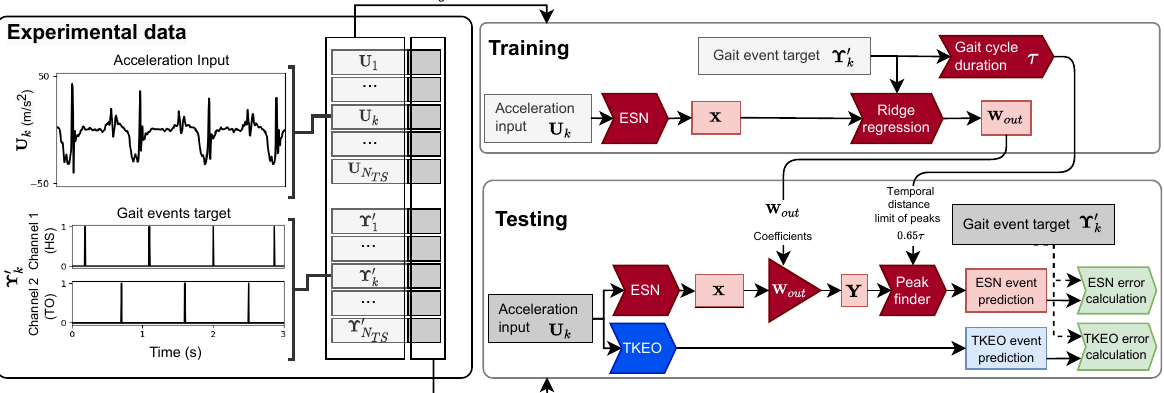
Figure 1. Procedure used to evaluate the performance of the ESN and the TKEO algorithms. Arrow boxes represent calculation steps and square boxes represent data. The experimental data were collected during walking tests as explained in Section 2.1 and preprocessed as explained in Section 2.2. The input timeseries U k is acceleration signals recorded on the participant left foot. The output timeseries Υ (cid:48) is the gait event targets identified with ground force sensors and formatted as a k multi-channel binary signal. Each channel indicated the event time indices of one gait event class. } , and the outputs { Υ (cid:48) } represent a ,..., Υ (cid:48) ,..., Υ (cid:48) The timeseries lists of the inputs { U 1 ,..., U k ,..., U N 1 N TS k TS subset of multiple input and output timeseries for each participant and walking condition considered in the procedure. The timeseries are separated in two groups, one for the training step of the ESN algorithm and one for the testing step of both ESN and TKEO algorithms. The ESN algorithm steps are represented by the red boxes and explained in Section 2.3. The TKEO algorithm steps are represented by the blue boxes and explained in Section 2.4. The green boxes evaluate the error between predicted and target events and establish performance criteria as presented in Section